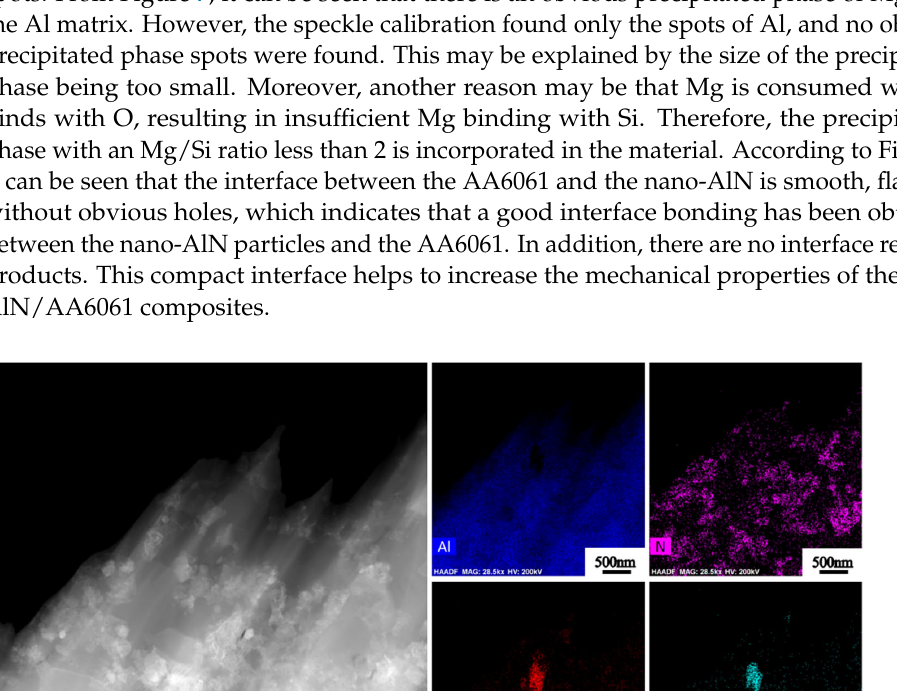
Figure 8. HRTEM of nano ‐ AlN/AA6061 after HE: ( a ) Interface of nano ‐ AlN and AA6061; ( b , c ) the FFT result of the selected region. 3.3. Machinal Properties of Nano ‐ AlN/AA6061 The grain sizes of the as ‐ cast composites and the composites after HE are shown in Figure 9. After HE treatment, the average grain size of the AA6061 in the composites has been extremely refined. The grain size of the as ‐ cast material is mainly distributed be ‐ tween 2 and 20 μ m, and the grain sizes of the composites after HE are mainly distributed between 1 and 3 μ m. It has been widely noted in the Al matrix composites that the hot ‐ extruded treatment has an obvious effect of grain refinement, developing the interfacial bonding and directional arrangement of the reinforcements which are valuable for the improvement in the mechanical properties of the composites.